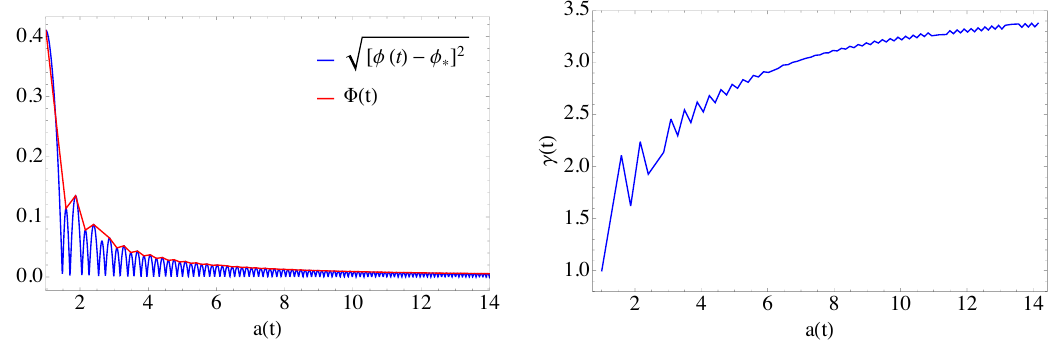
p Figure 20 . Left: [ (cid:30) ( t ) (cid:0) (cid:30) (cid:3) ] 2 vs. a ( t ) (blue) and its envelope (cid:8)( t ) computed at times at which _ (cid:30) = 0. Right: evolution (cid:13) ( t ) (cf. equation (A.8)). (cid:13) ( t ) re(cid:13)ects the growth of the (cid:13)uctuations relative to the amplitude of the homogeneous